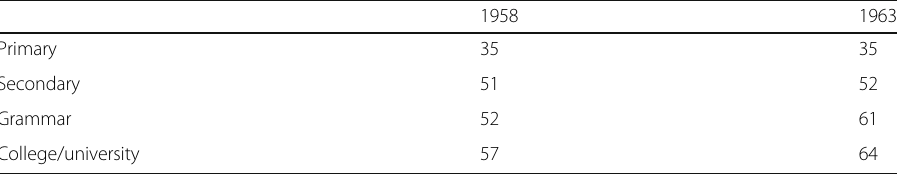
Table 13 Percent of completely or partly planned births, according to wife ’ s education, Netherlands, 1969, marriage cohorts 1958 and